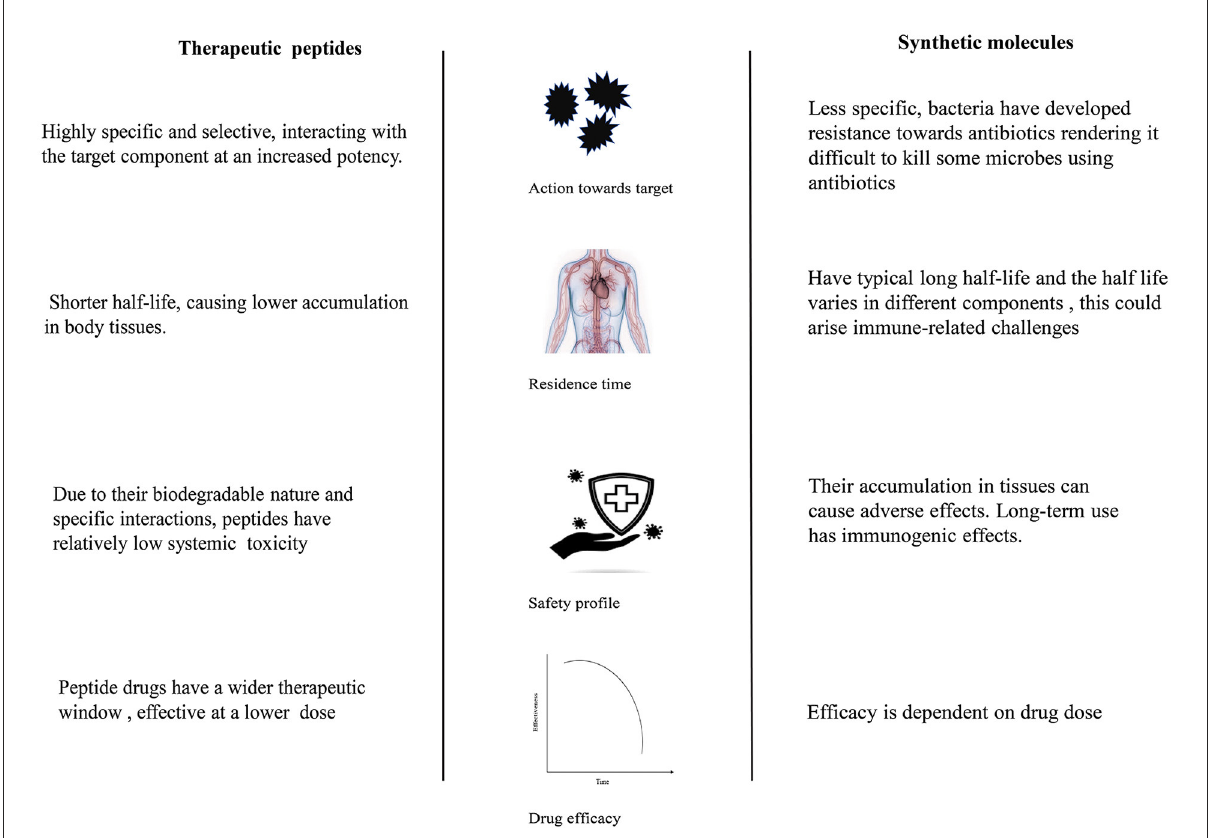
FIGURE2 The advantages of therapeutic peptides over synthetic drugs.